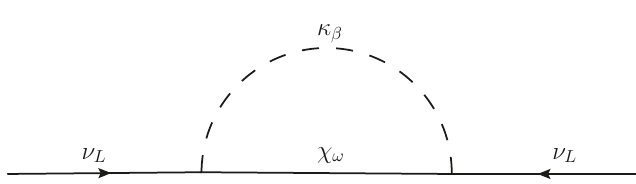
Figure 1 . One-loop diagram leading to neutrino Majorana